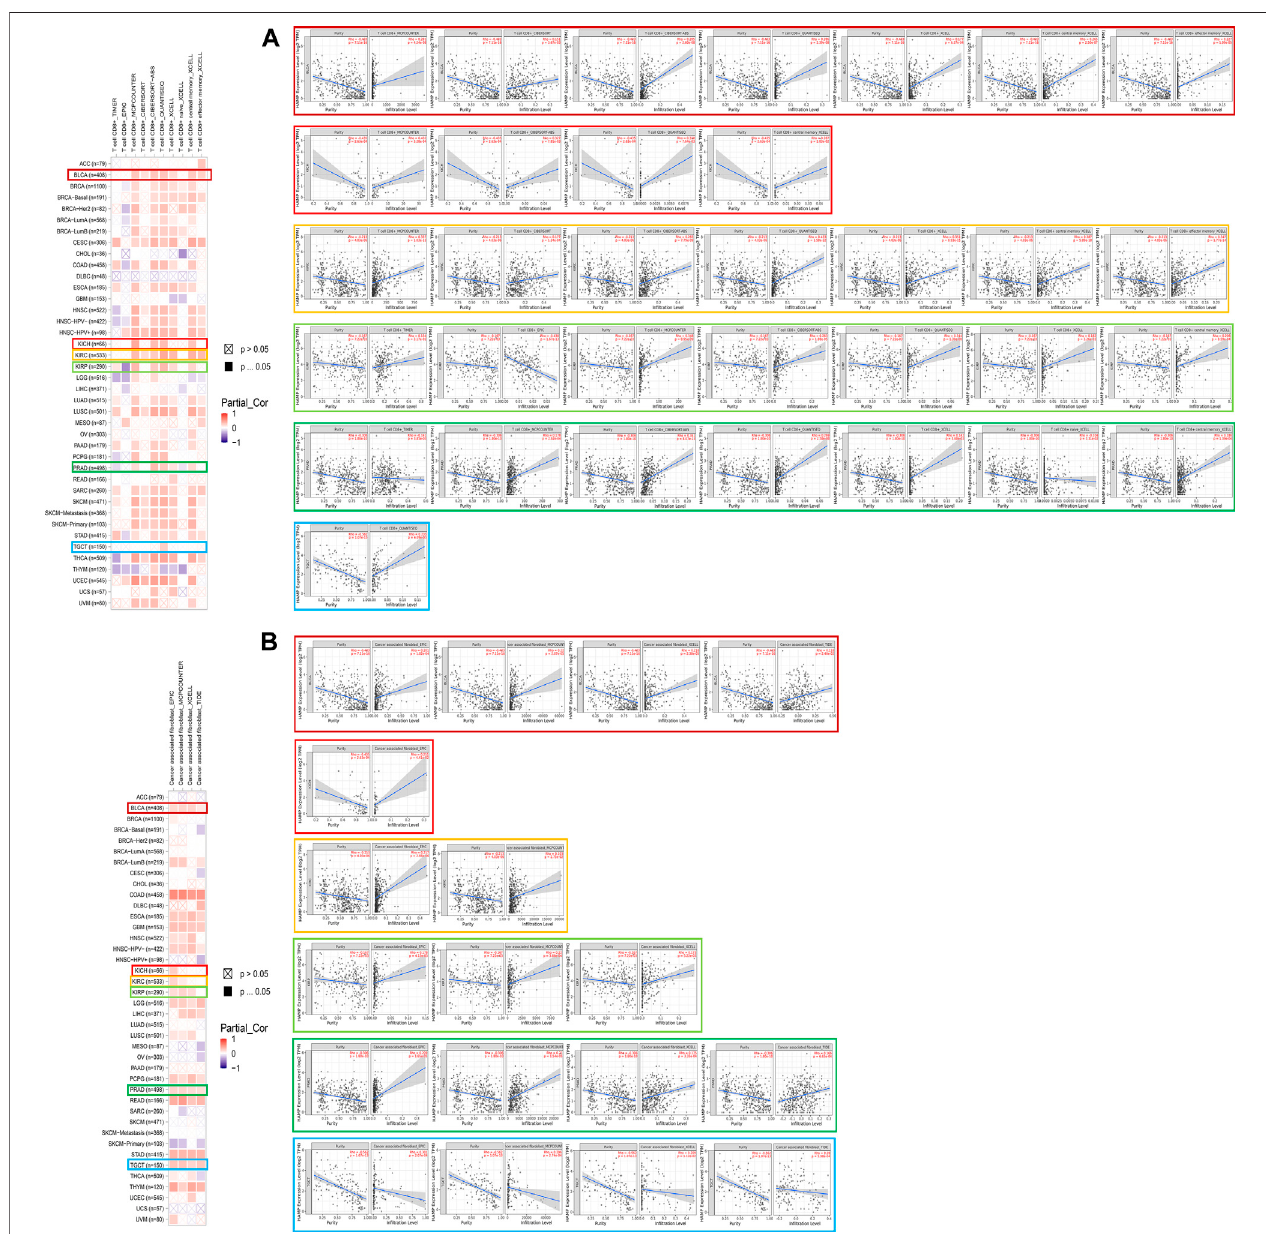
FIGURE 5 | Association between hepcidin and immune in fi ltration of (A) CD8 + T cells and (B) tumor-associated fi broblast in male genitourinary system tumors in TCGA.